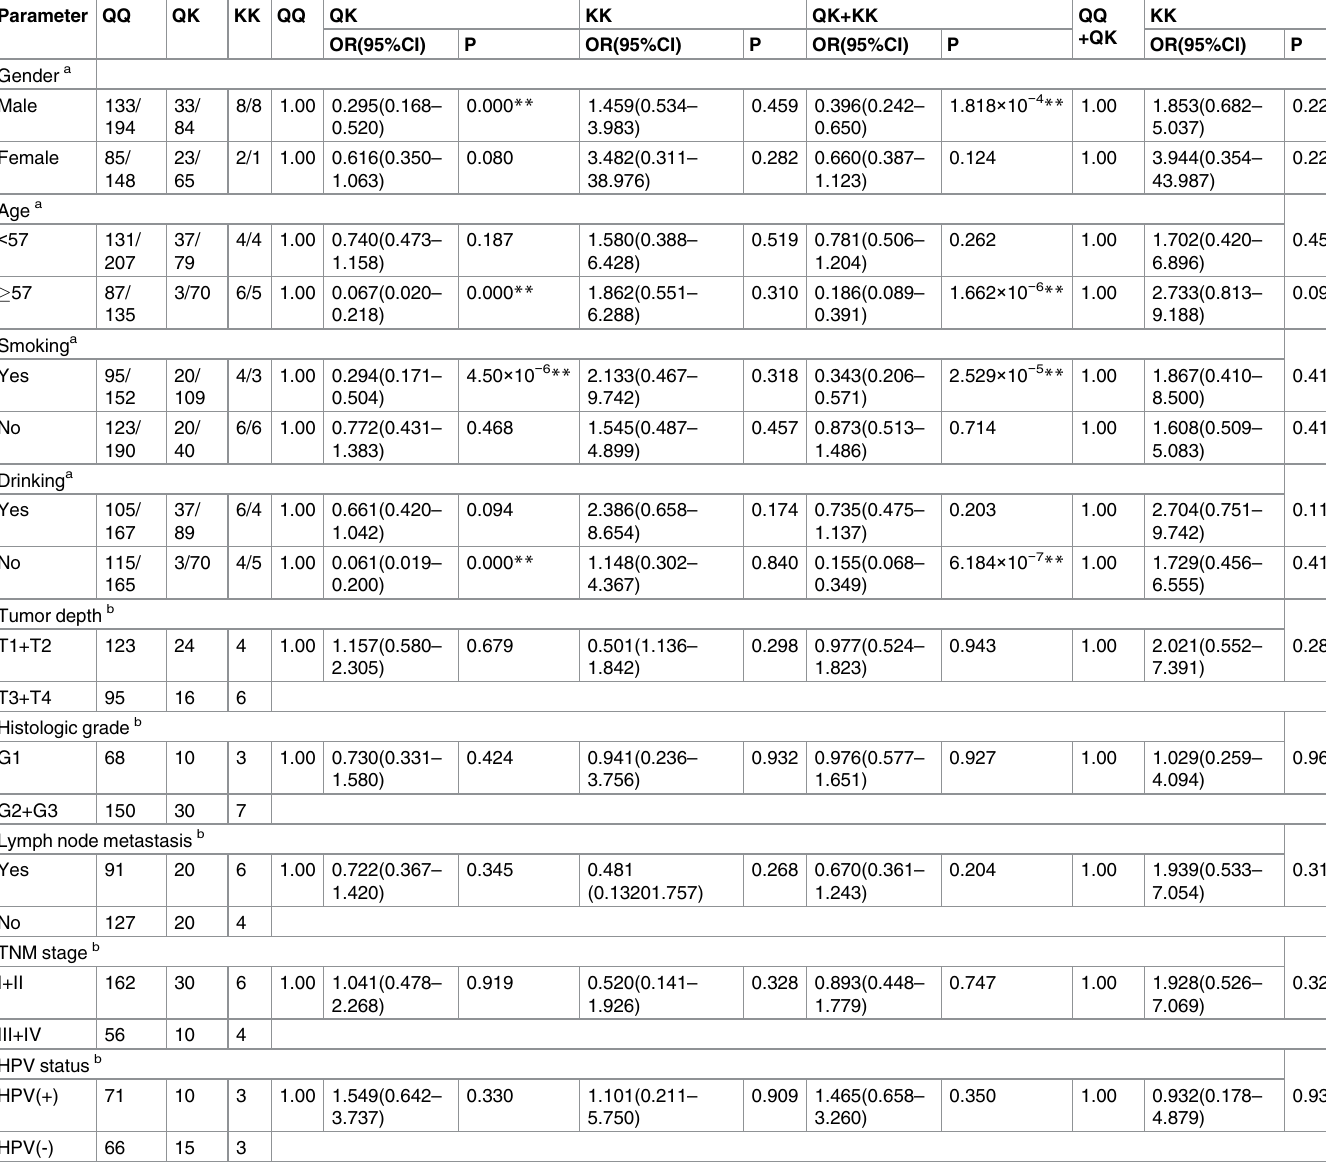
Table 4. Stratification analyses between LMP7 polymorphism and clinicopathological parameters of Kazakh ESCC